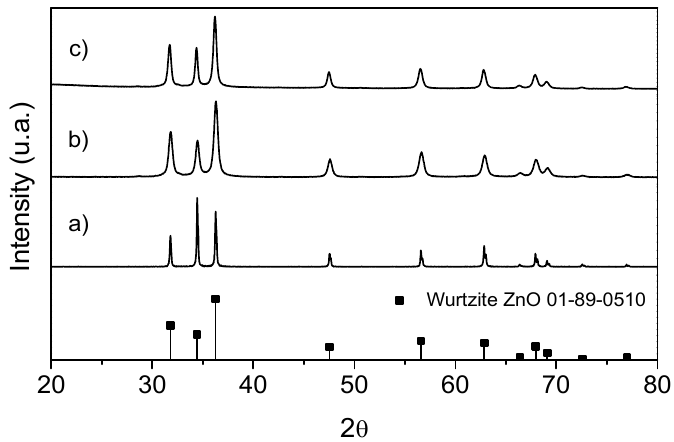
Figure 6. ZnO nanoparticle X-ray diffractogram. ( a ) Spherical ZnO-NP, ( b ) hexagonal ZnO-NP and ( c ) maltodextrin-modified ZnO-NP.